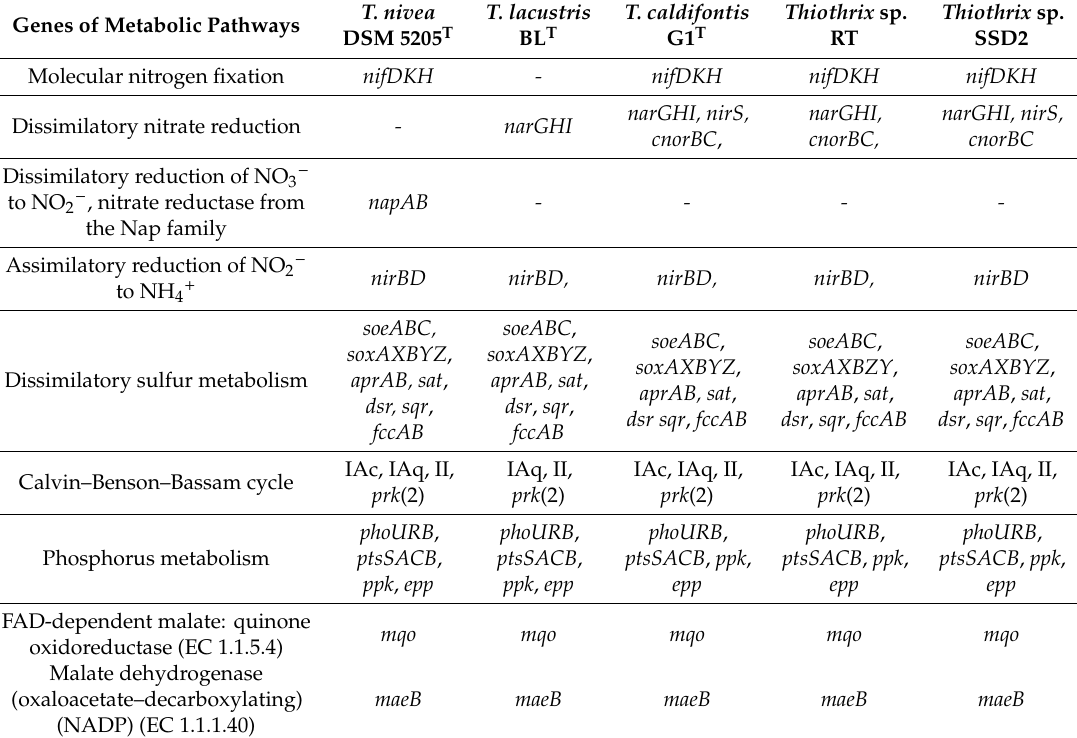
Table 1. Genes for nitrogen, sulfur, phosphorus metabolism and key enzymes of the Calvin–Benson– Bassham